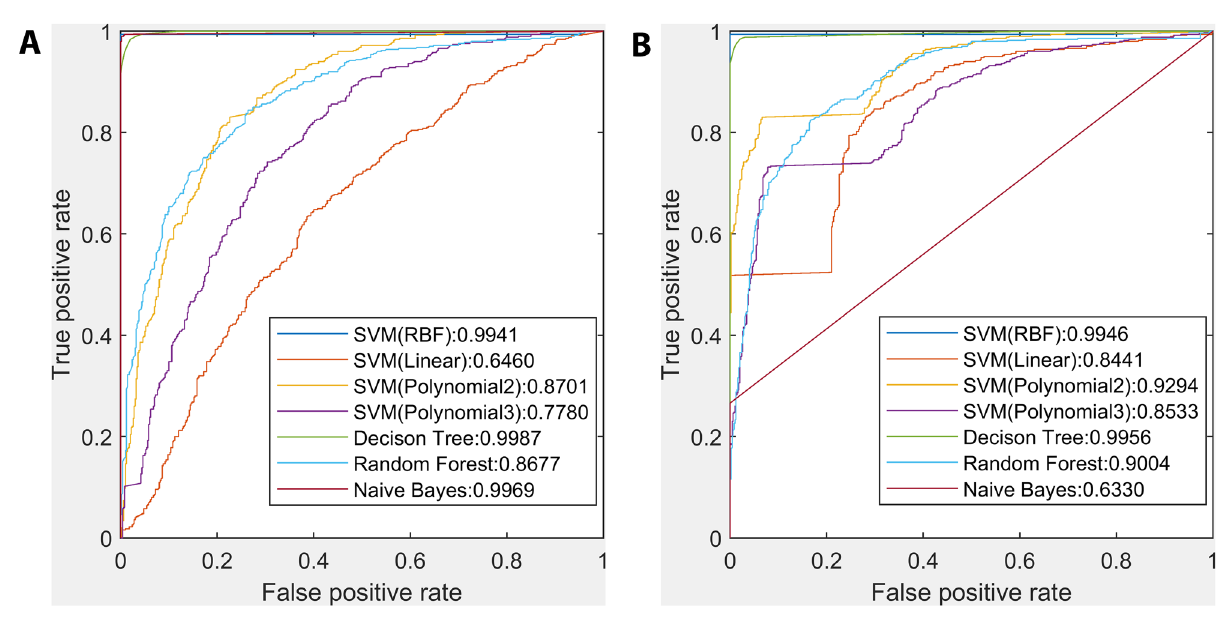
Figure 3. Comparison between the performance of different classifiers in prediction of genes with similar tissue-wide expression profiles to NR3C1 . ( A ) ROC curves and AUC of seven classifiers without intersecting promoters with DHSs. ( B ) ROC curves and AUC of seven classifiers after intersecting promoters with DHSs. The Decision Tree classifier exhibited the largest AUC under both scenarios, and inclusion of DHS information significantly improved other classifiers’ AUC except for Naïve